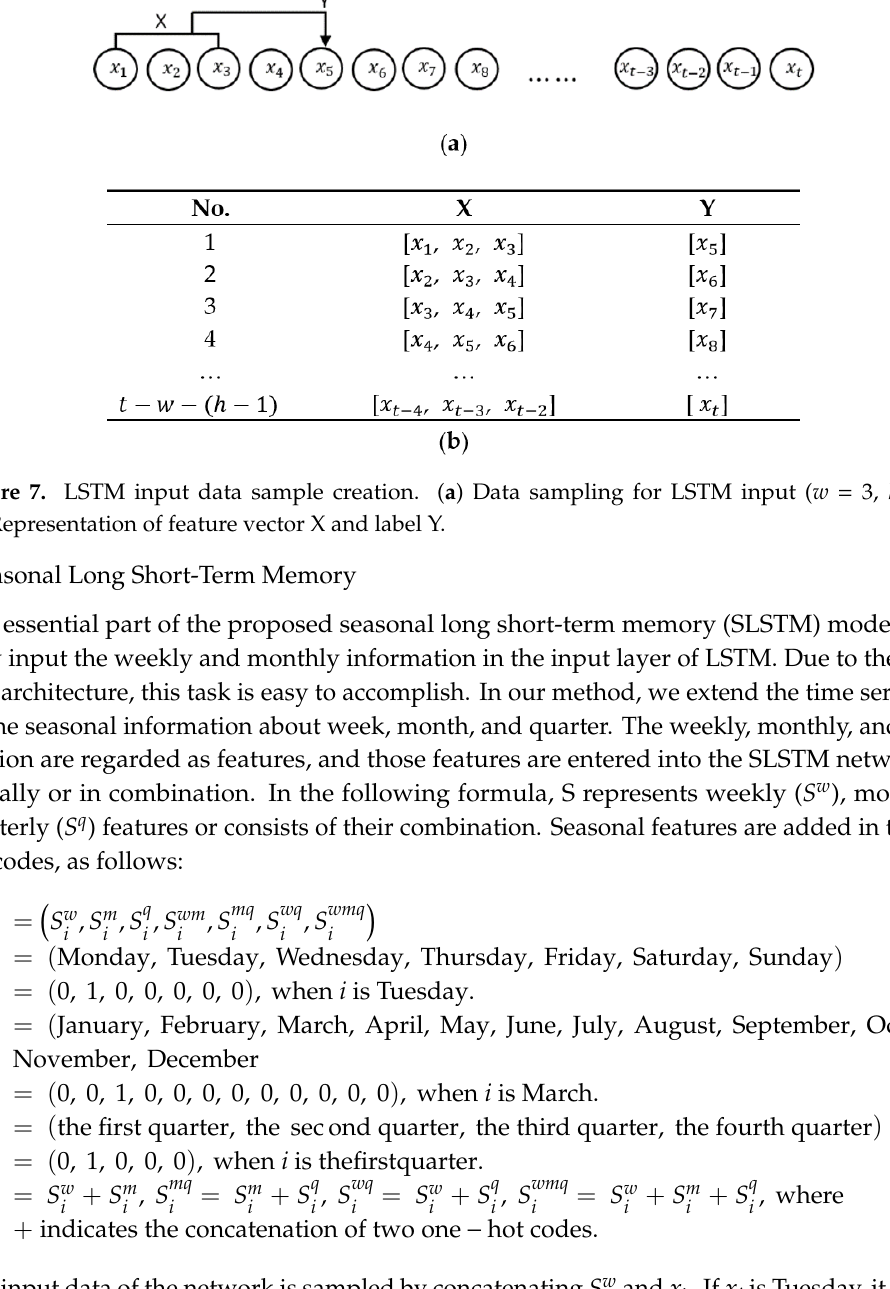
10 of 16 Figure 6. Schematic representation of long short-term memory (LSTM) model. Activation functions that are commonly used in the LSTM network are sigmoid and hyperbolic tangent [12,24]. These activation functions of LSTM are calculated for forget gate 𝑓 𝑡 , input gate 𝑖 𝑡 , output gate 𝑜 𝑡 , candidate vector 𝑐′ 𝑡 , cell state 𝑐 𝑡 , and hidden state ℎ 𝑡 using the following formulae, respectively: 𝑓 𝑡 = 𝜎(𝑤 𝑥𝑓 𝑥 𝑡 + 𝑤 ℎ𝑓 ℎ 𝑡−1 + 𝑏 𝑓 ) 𝑖 𝑡 = 𝜎(𝑤 𝑥𝑖 + 𝑤 ℎ𝑖 ℎ 𝑡−1 + 𝑏 𝑖 ) 𝑐′ 𝑡 = 𝑡𝑎𝑛ℎ(𝑤 𝑥𝑐′ 𝑥 𝑡 + 𝑤 ℎ𝑐′ ℎ 𝑡−1 + 𝑏 𝑐′ ) 𝑜 𝑡 = 𝜎(𝑤 𝑥𝑜 𝑥 𝑡 + 𝑤 ℎ𝑜 ℎ 𝑡−1 + 𝑏 𝑜 ) 𝑐 𝑡 = 𝑓 𝑡 ∗ 𝑐 𝑡−1 + 𝑖 𝑡 ∗ 𝑐′ 𝑡 ℎ 𝑡 = 𝑜 𝑡 ∗ 𝑡𝑎𝑛ℎ (𝑐 𝑡 )